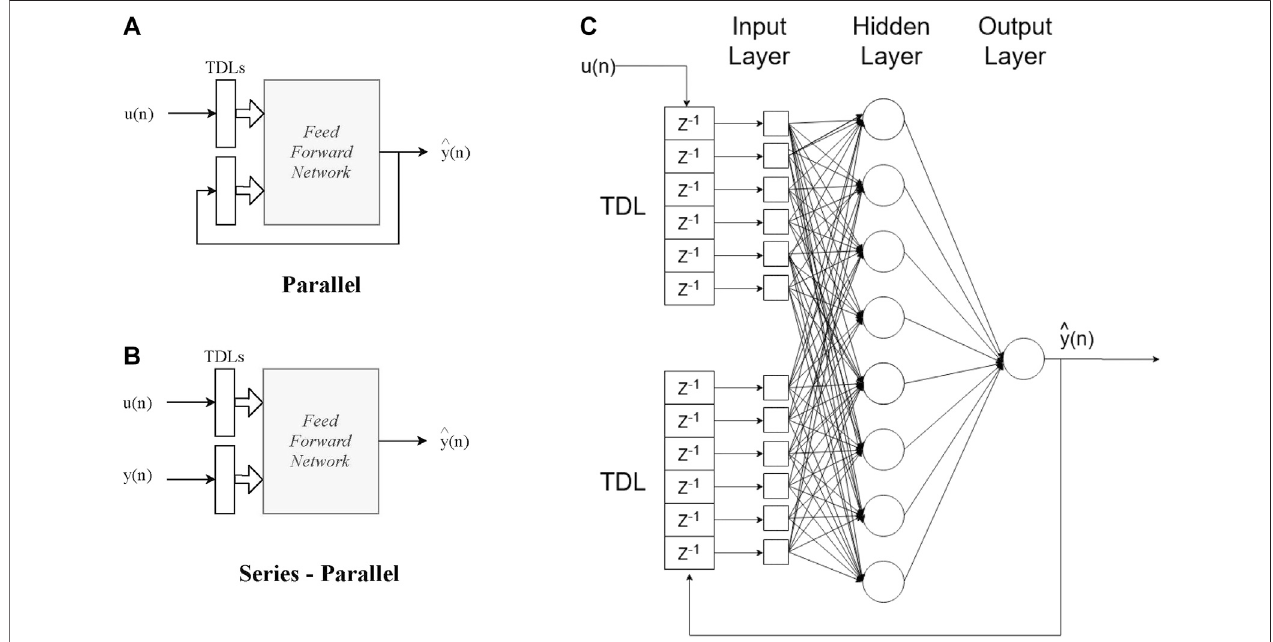
FIGURE 1 | Con fi guration of NARX. (A) Parallel and (B) Series-Parallel modes (C) NARX architecture utilized in this study.